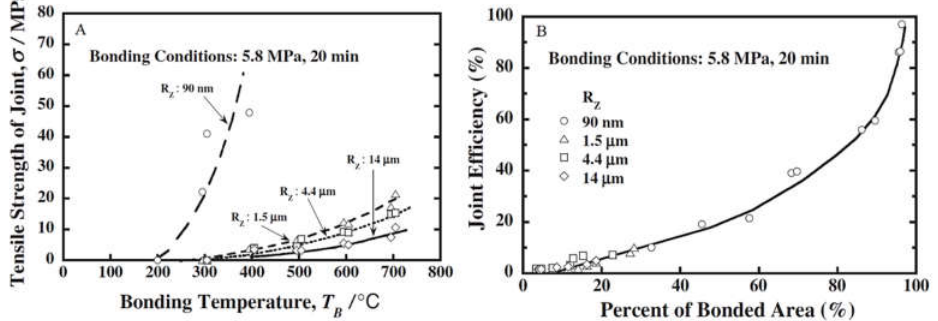
Figure 5. ( A ) Relationship between the tensile strength of joints and bonding temperature for various surfaces prepared by lathe machining method. ( B ) Relationship between joint efficiency and percentage of the bonded area for multiple surfaces [63].